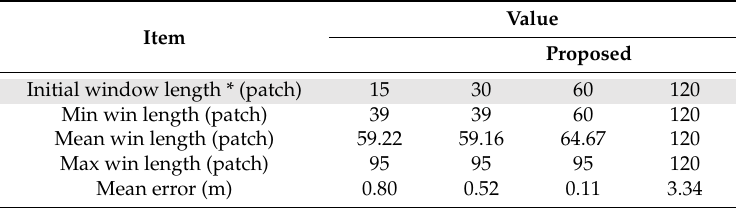
Table 5. Evaluation of the sensitivity of the framework to different initial window lengths. Value Item Proposed Item Initial window length * (patch) Item